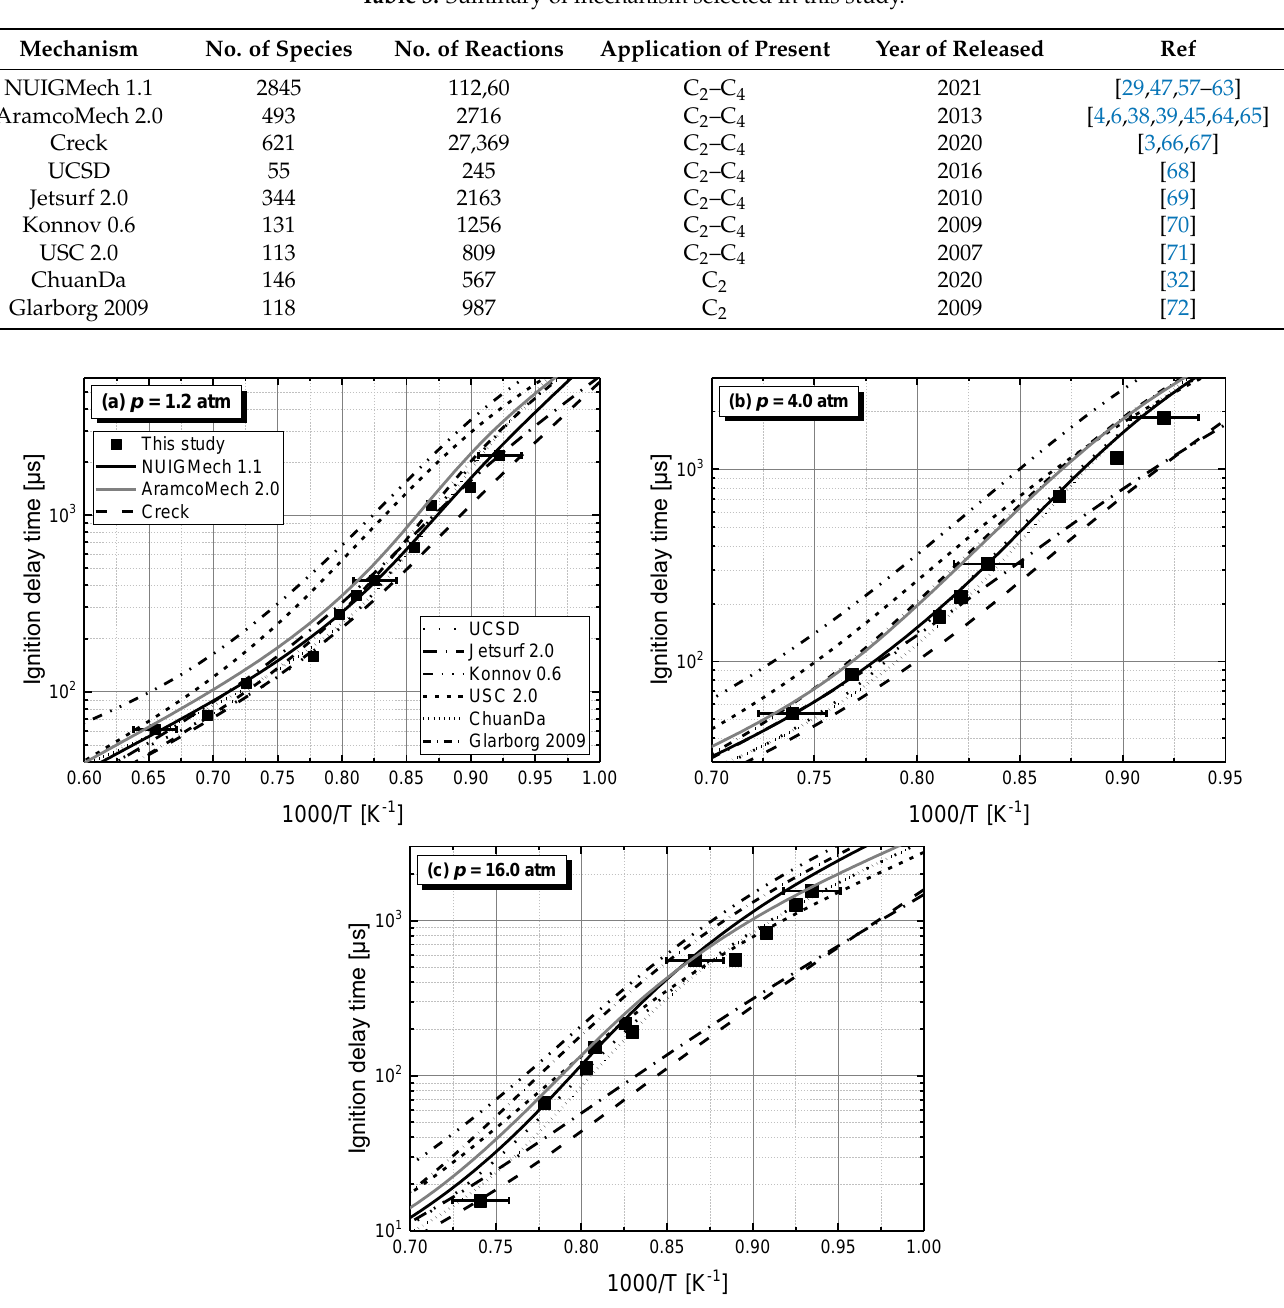
Figure 6. Comparison of measured and simulated IDTs of ethylene with RCM at 30 atm ( a ) and 40 atm ( b ). Symbols: experiments from Dong et al. [29] and Badigmohammadi et al. [28], lines: model simulations. For propene, both NUIGMech 1.1 and AramcoMech 2.0 predict fairly well the IDT at all three pressures, (Figure 7). Creck, Jetsurf 2.0 and USC 2.0 give acceptable agreement at 1.2 and 4.0 atm at whole temperatures, but show different levels of under-prediction at 16.0 atm and lower temperature. Besides, UCSD exhibits mildly higher reactivity at all